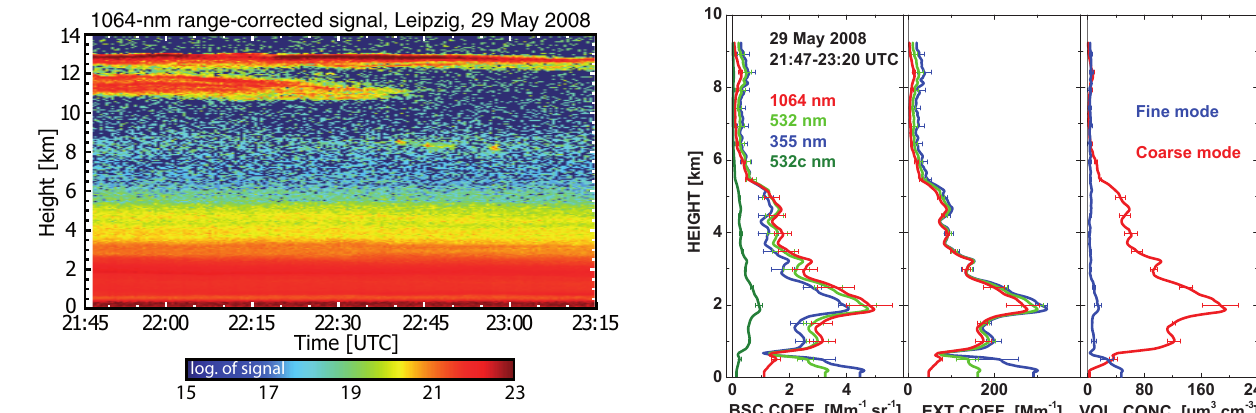
Fig. 5. Comparison of LIRIC– and POLIPHON–derived parti- cle mass concentrations, observed on 29 May 2008. The blue POLIPHON curves are taken from Figure 2 of Ansmann et al. (2012). Error bars indicate the uncertainties (one standard devia- tion).